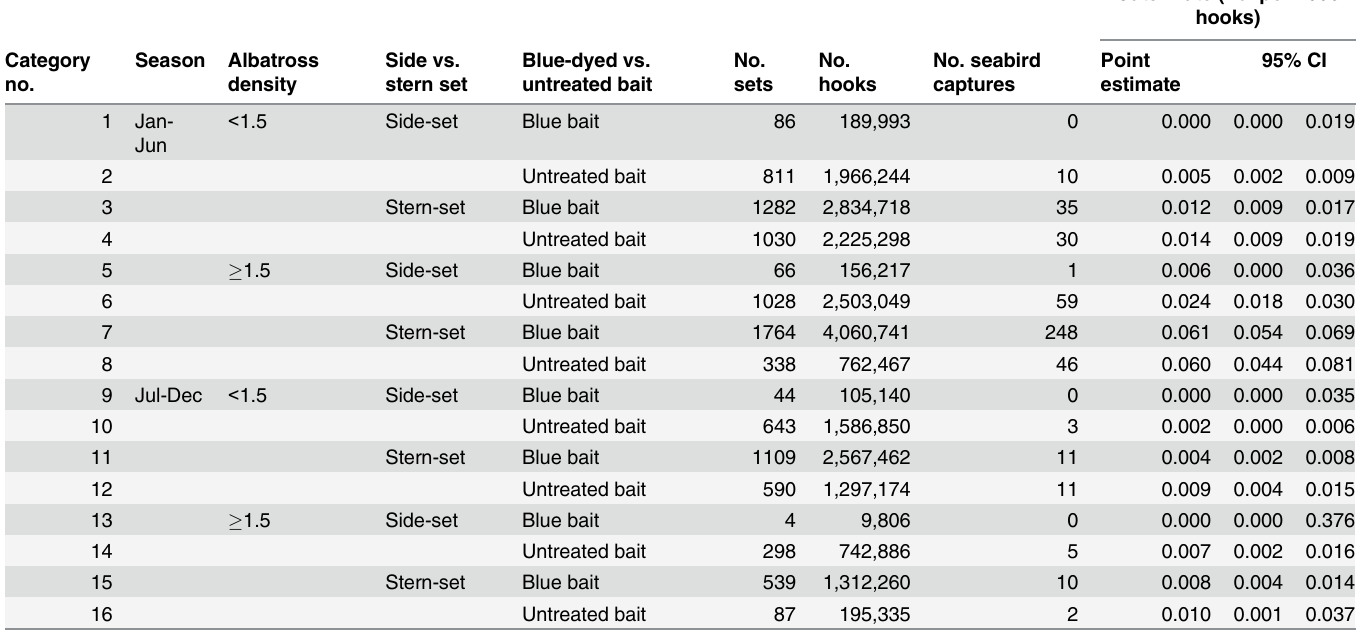
Catch rate (no. per 1000 hooks)